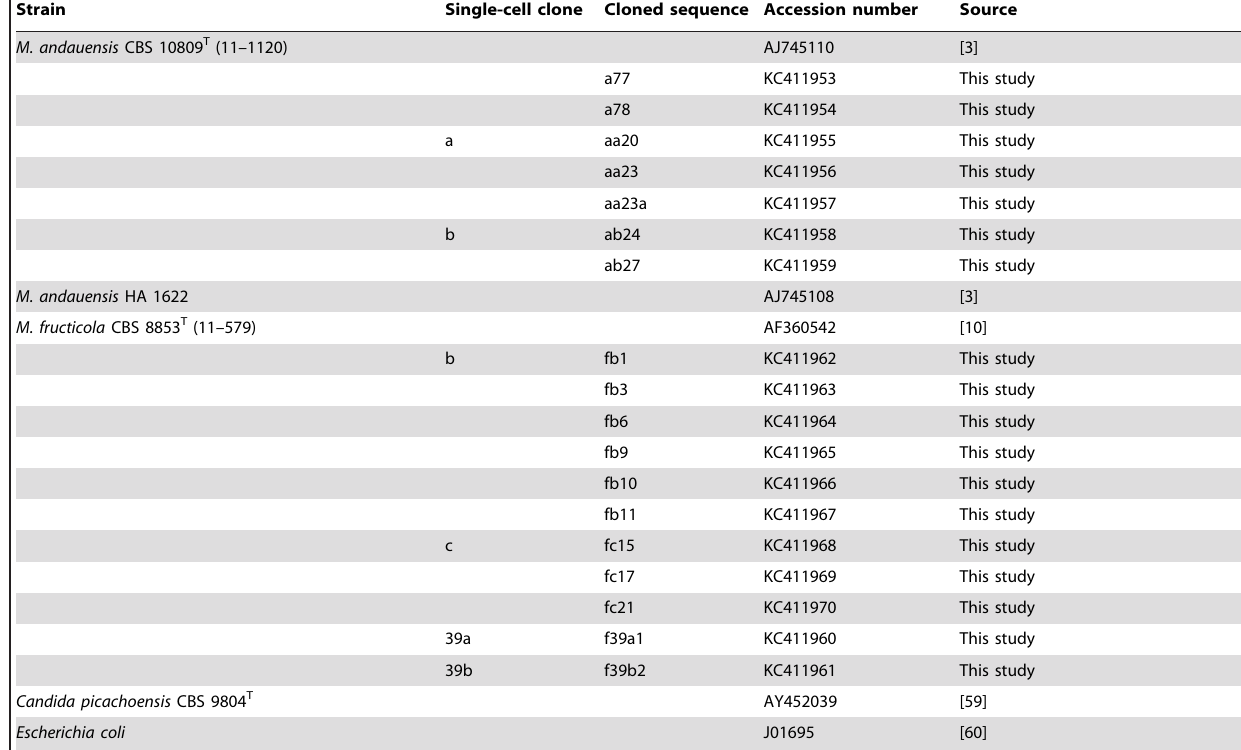
Table 1. List of strains and